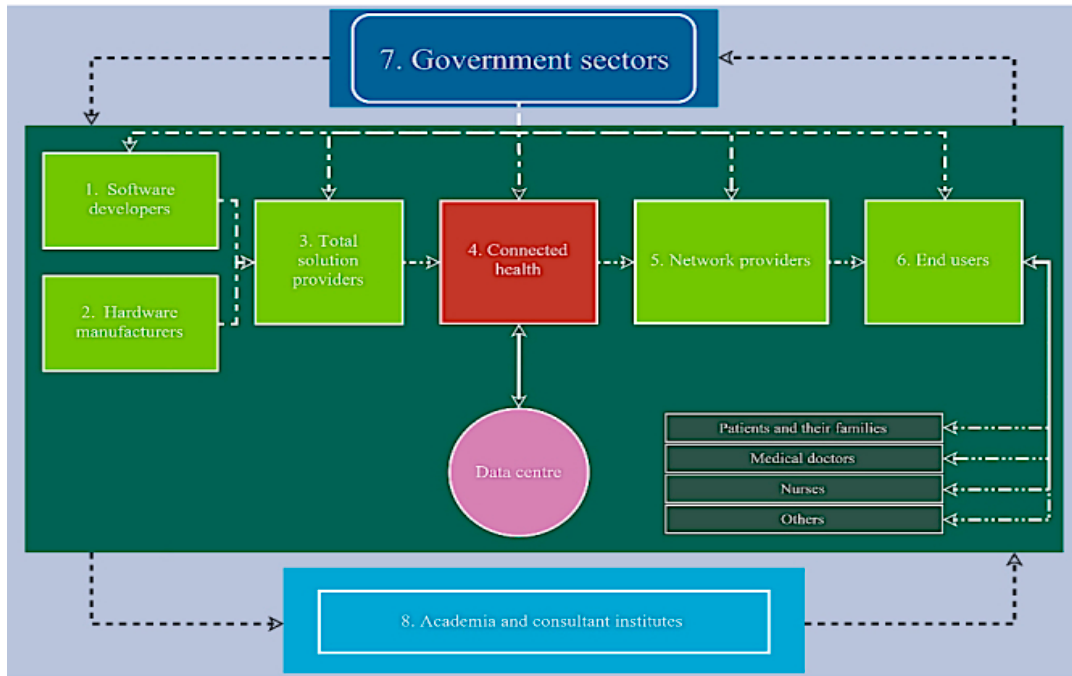
Figure 4. CH players and stakeholders’ relationship diagram [43]. Table 5. Interviewees’